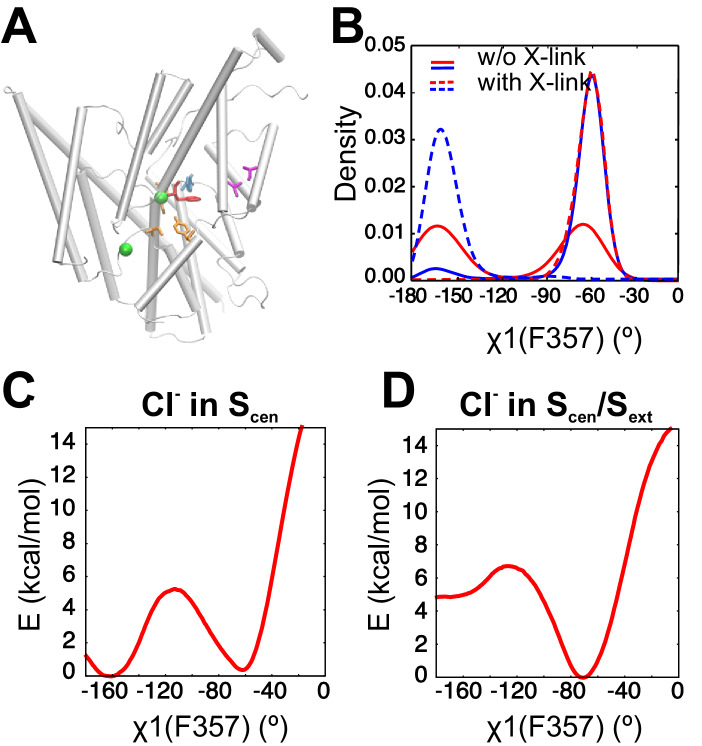
A crosslink known to reduce transport activity impedes the reorientation of the F357 side chain.(A) Molecular graphic shows the position of the engineered crosslink within a CLC-ec1 monomer with the A399C-A432C crosslink in magenta sticks, the Cl- coordinating residues (S107, E148 and Y445) in orange sticks, Phecen (F357) and Phex (F190) respectively as red and blue sticks, and Cl- ions as green spheres. For clarity, residues 250 to 285 are not shown. (B) The distribution of F357 χ1 angle is shown for simulations in absence and presence of the engineered crosslink. Two independent simulations are shown for each case. In presence of the crosslink, no transition is observed between the two rotameric states of F357. (C, D) The PMFs along F357 χ1 angle shown in Figure 2—figure supplement 1E,F are repeated here in presence of the crosslink, with a Cl- in Scen (C) and Cl- in both Scen and Sext (D). The PMF calculations were initiated with the F357 side chain in the down state (χ1=-70°). The Cys bridge impedes the transition of F357 toward its up state (χ1=-160°).